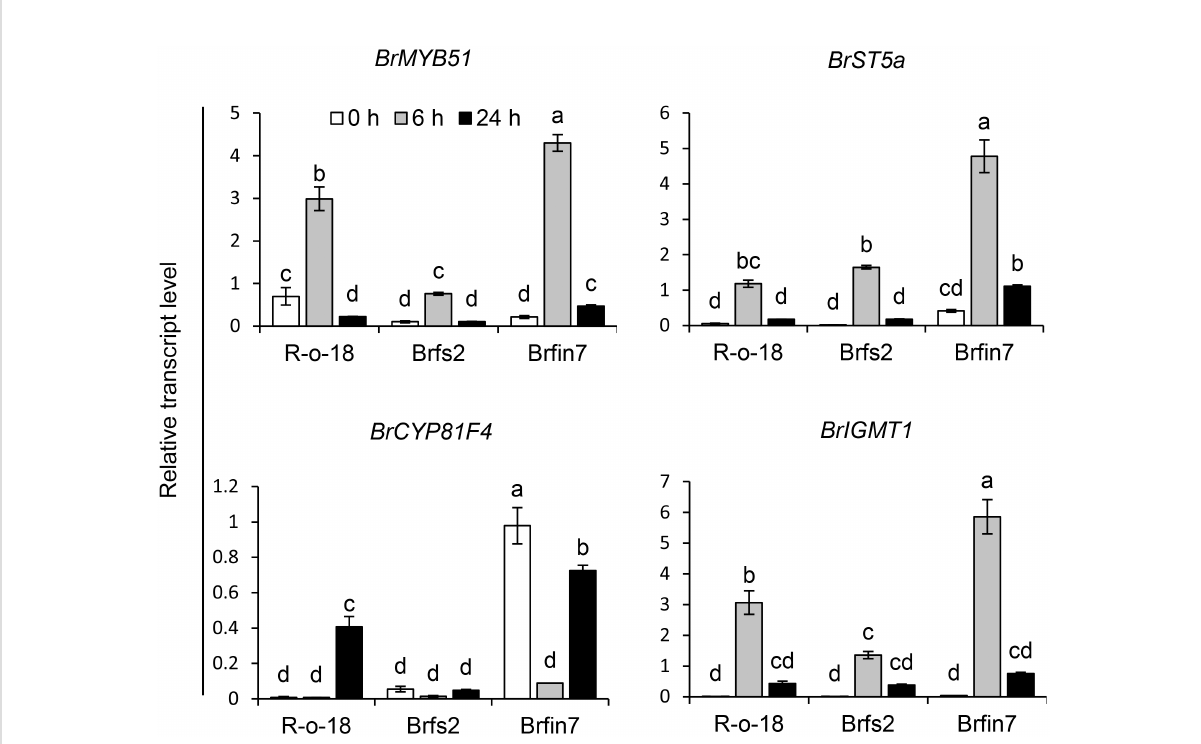
FIGURE 7 Analysis of the expression patterns of indole glucosinolate biosynthesis genes in B. rapa after the P. brasiliense inoculation. Transcript levels of indole glucosinolate biosynthesis genes in R-o-18, Br fs2, and Br fi n7 plants. Four-week-old B. rapa plants were inoculated with P. brasiliense and sampled at the indicated post-infection time-points. The BrMYP51 , BrST5a , BrCYP81F4 , and BrIGMT1 transcript levels were determined by qRT- PCR. Gene transcript levels were normalized against the ACT2 transcript level. Error bars represent standard deviations of three replications. Similar results were obtained in at least two independent experiments. Different letters indicate signi fi cant differences among plant genotypes ( a = 0.01, one-way ANOVA and Tukey HSD test; SPSS